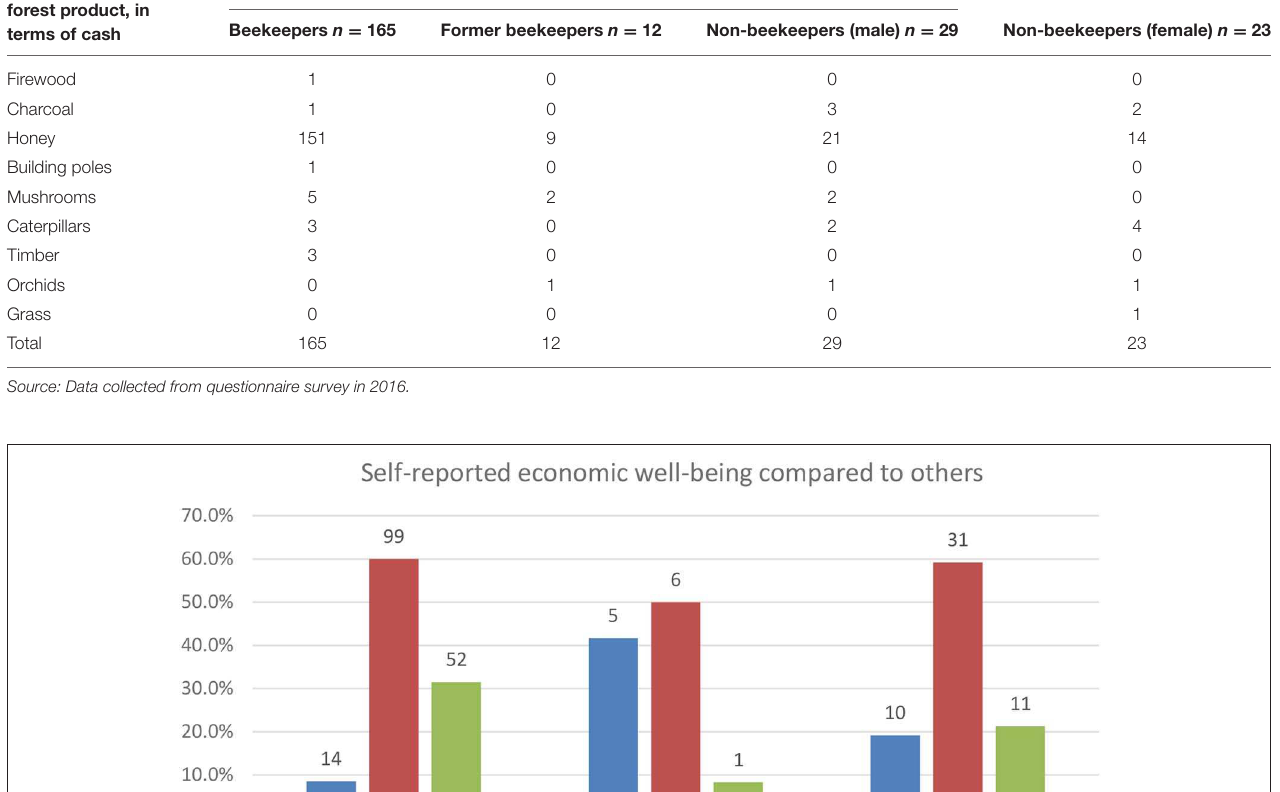
TABLE 4 | Most important forest product, in terms of cash generation, for the community as a whole and regardless of whether the respondent benefitted personally. Most important forest product, in